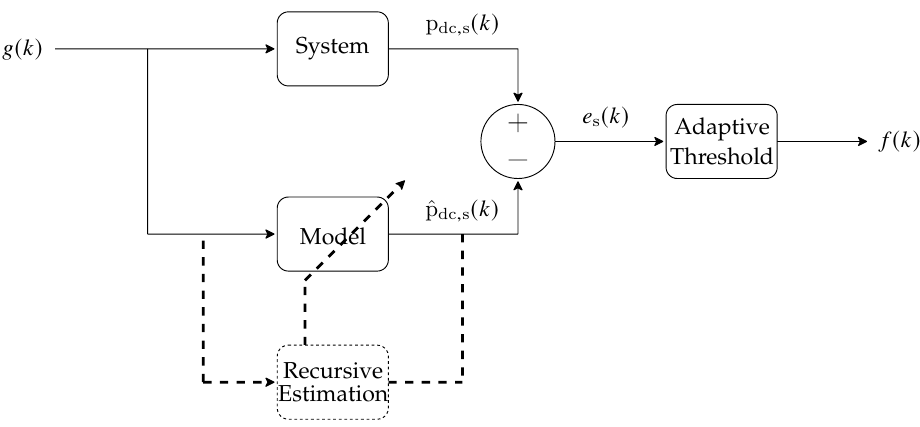
Figure 9: The proposed method consists in transmitting a frame using ⌈ α n cha ⌉ channel uses for the fi rst trans- Figure 8. Example of an output error model, with instantaneous irradiance g ( k ) as an input, an instant mission attempt, with 0 < α ≤ 1 . In the event of a decoding error, incremental redundancy is transmitted power p dc,s ( k ) as output, an estimated output ˆp dc,s ( k ) , an error e ( k ) , and a fault f ( k ) 1 − α n cha ⌋ channel uses. making use of the rest of the available ⌊ ( )